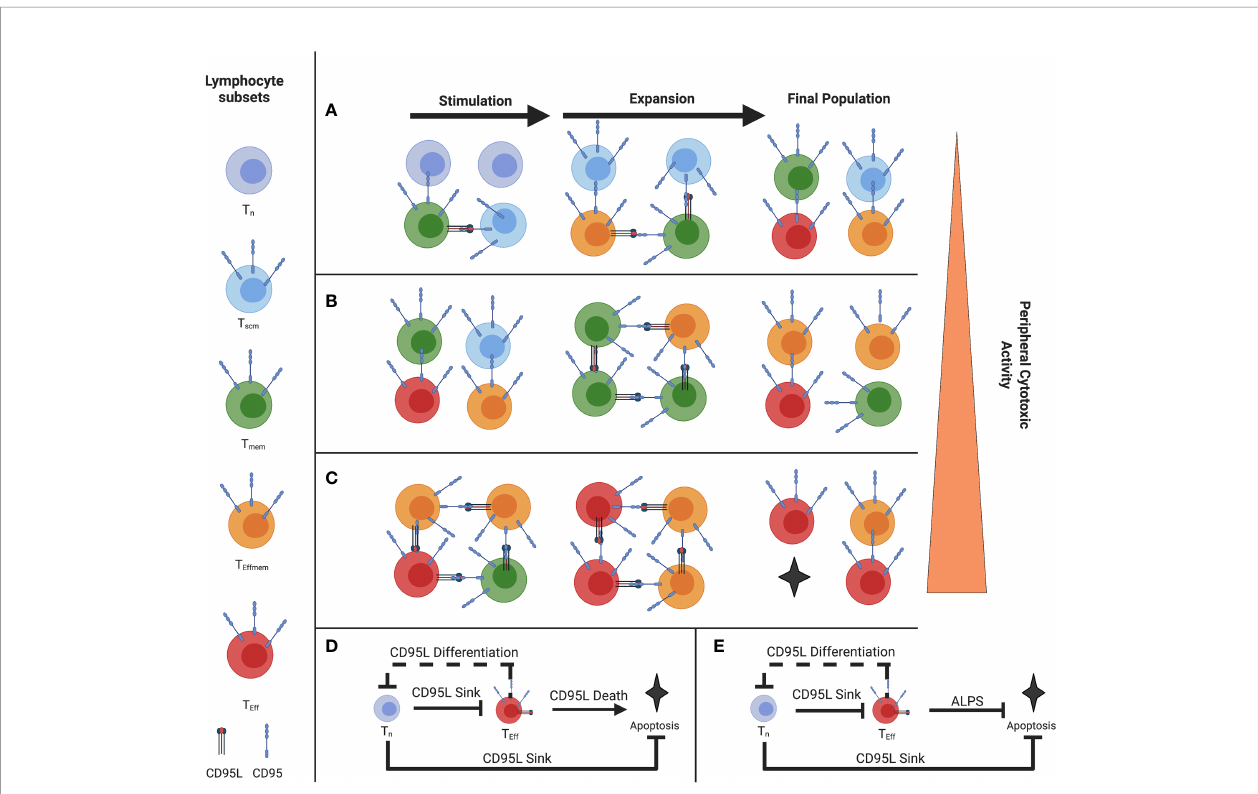
FIGURE 1 | Illustration of the Paracrine Fas/FasL differentiation and death system (A) Stimulation of a naive-rich pool of T-cells corresponding to a youthful repertoire (B) Stimulation of a more differentiated pool of T-cells (C) Stimulation of a pool of T-cells with few Tn, where the population will reach cytotoxic function more exuberantly (D) Proposed coherent type 2 Feed-Forward Loop of Fas-mediated differentiation and death (solid line), with a negative feedback loop on naive T cells from effector T cells (E) FFL error from coherent type 2 to incoherent type 2 in ALPS and the murine model Fas C194V due to a defect in CD95-mediated Apoptosis but not CD95-mediated differentiation. (Figure adapted with permission from Leonardi and Proenca,